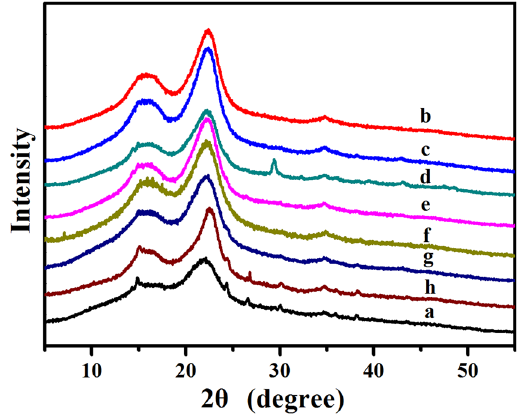
Figure 3. XRD patterns, ( a ) untreated CS; ( b ) 3% KOH-treated CS; ( c ) 1.5% NaOH-treated CS; ( d ) 1%